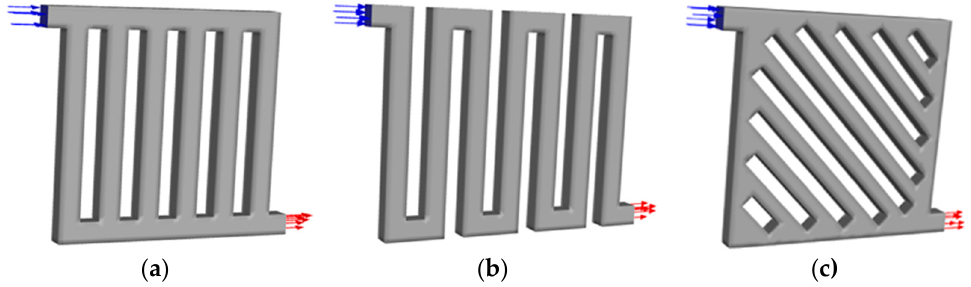
Figure 1. Computational domain of flow field models with arrow indicating the flow direction: ( a ) parallel; ( b ) serpentine; and ( c ) symmetry.